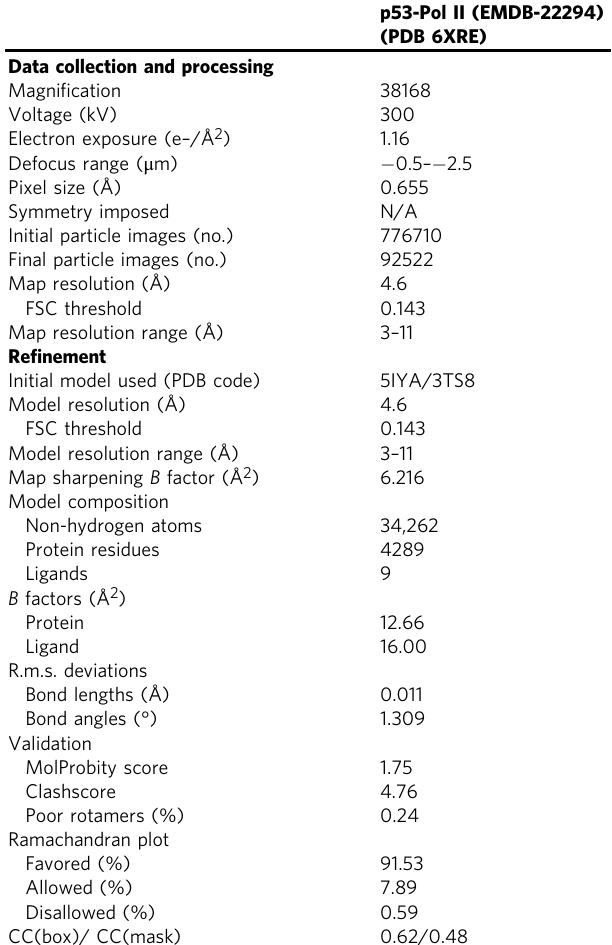
Table 1 Cryo-EM data collection, re fi nement and validations